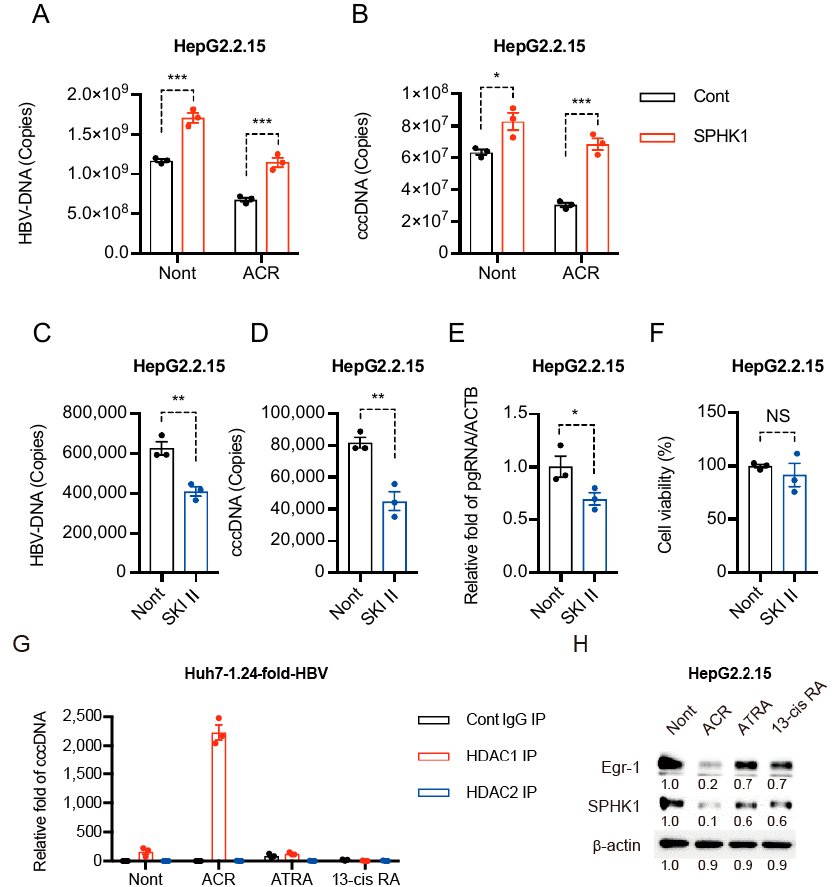
Figure 4. Peretinoin enhances HDAC1-cccDNA binding activity via the suppression of SPHK1 activity. ( A , B ) A plasmid encoding SPHK1 or a control empty vector was transfected into HepG2.2.15 cells and 24 h after transfection, 0 or 30 μ M of peretinoin was added for 5 days. ( A ) HBV-DNA levels were analyzed by qPCR. ( B ) cccDNA levels were analyzed by qPCR. ( C – F ) HepG2.2.15 cells were treated with 0 or 10 μ M of SKI II for 3 days. ( C ) HBV-DNA levels were analyzed by qPCR. ( D ) cccDNA levels were analyzed by qPCR. ( E ) Pregenomic RNA levels of HBV were analyzed by RTD-PCR, and pregenomic RNA levels were normalized against the β -actin mRNA level. ( F ) Cytotoxicity was analyzed by MTT assay. ( G ) Huh7 cells were transfected with 1.24-fold-HBV plasmid. Twenty-four hours after transfection, peretinoin, ATRA, or 13- cis RA was added for 3 days. Chromatin was immunoprecipitated with the control IgG or anti-HDAC1 antibodies and analyzed by qPCR with HBV cccDNA selective primers. ( H ) HepG2.2.15 cells were treated with 30 μ M of peretinoin, ATRA, or 13- cis RA. Twenty-four hours after inoculation, Egr-1, SPHK1, and β -actin protein levels were determined by Western blotting analysis. The data are represented as means ± SEM from three independent experiments. * p < 0.05, ** p < 0.01, *** p < 0.001.